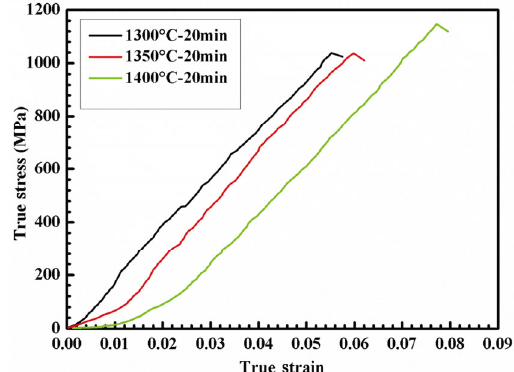
Fig. 12 True stress vs. true strain curves obtained from compression tests of the Ti 3 SiC 2 samples sintered under 60 MPa for 20 min at 1300, 1350, and 1400 ℃